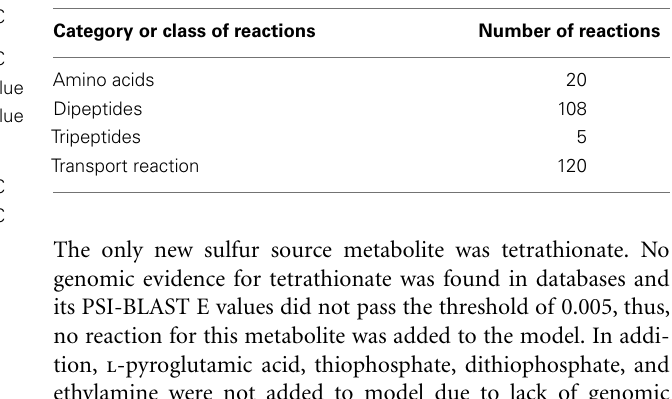
Table 3 | Summery of new reactions in iBD1106